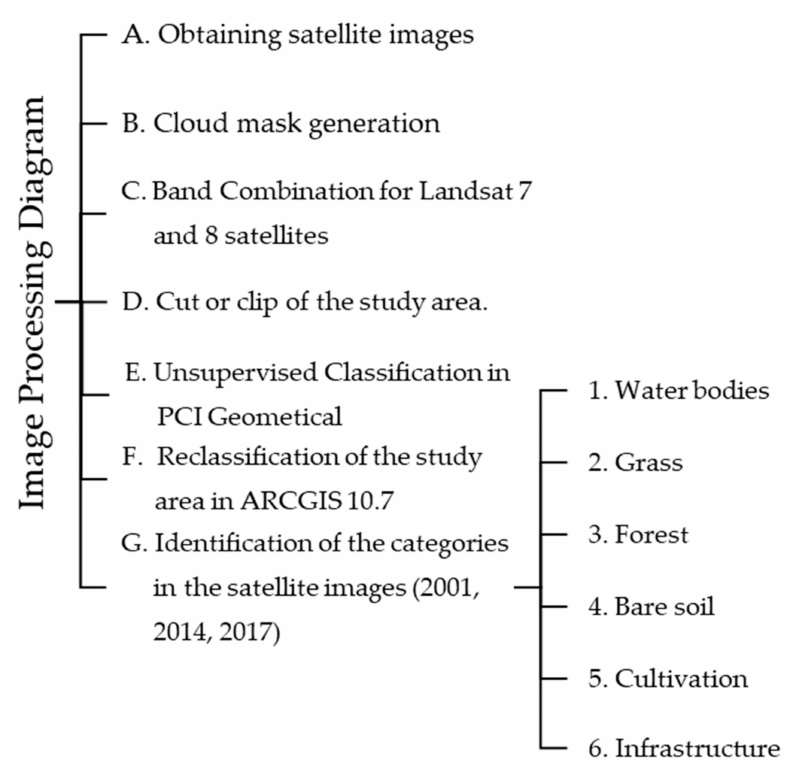
Figure 3. Satellite image processing flow chart for the three